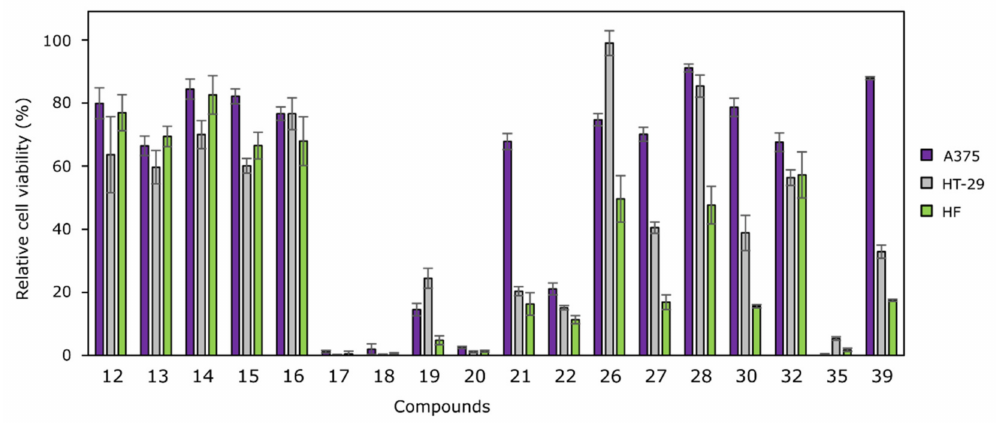
Figure 1. Effects of compounds 12 – 22 , 26 – 28 , 30 , 32 , 35 and 39 on cancer cell viability at 100 µ M against human melanoma (A375) and human colon cancer (HT-29) cell lines, and human fibroblasts HF. Cell lines were incubated with 100 µ M of compounds for 72 h. The cytotoxicity was measured using MTT assays. The cytotoxicity is represented as a percentage of viability, relative to the untreated cells (negative control, which is equal to 100%). N = 3.